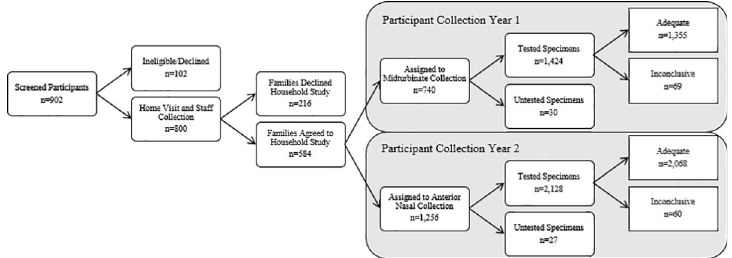
Fig 3. Study participant and specimen flowchart. From left to right and top to bottom, this flowchart shows the number of screened participants across both years of the study, the number of participants who declined or were ineligible for the ORCHARDS study, the number who were eligible for the ORCHARDS study and staff collection was conducted, the number of families who declined the Household Substudy, the number of families who agreed to participate in the Household Substudy, the number of participants assigned to midturbinate collection, the number of participants assigned to anterior nasal collection, the number of specimens that were collected and tested by RT-PCR, the number of specimens that were not tested (incomplete collection, leaking VTM, or positive influenza Ct with a negative human RP Ct), the number of adequate specimens, and the number of inconclusive/inadequate